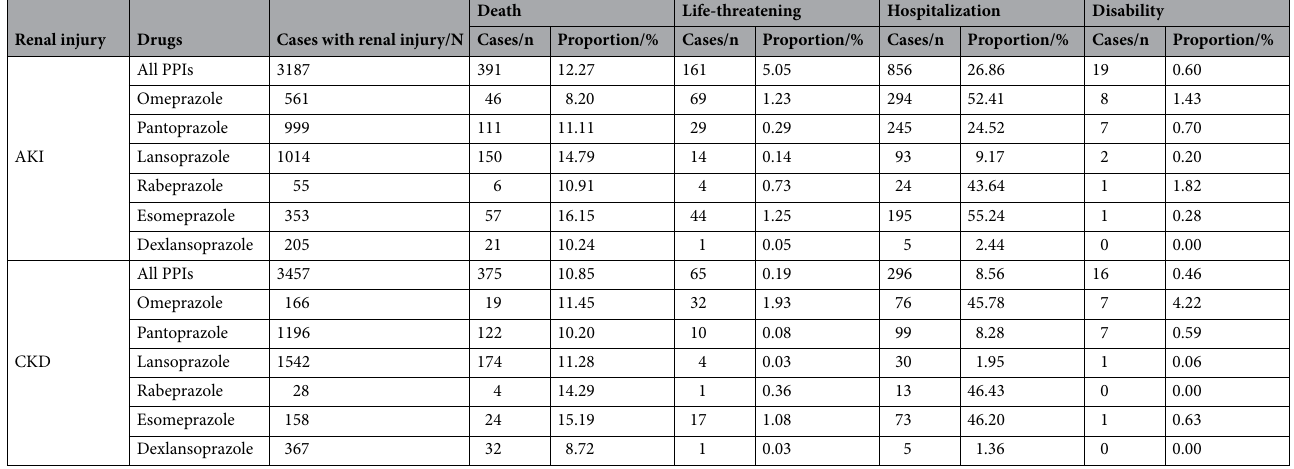
Table 3. Outcomes of cases reported as AKI and CDK using PPIs from FAERS database. PPIs proton pump inhibitors, AKI acute kidney injury, CKD chronic kidney disease.